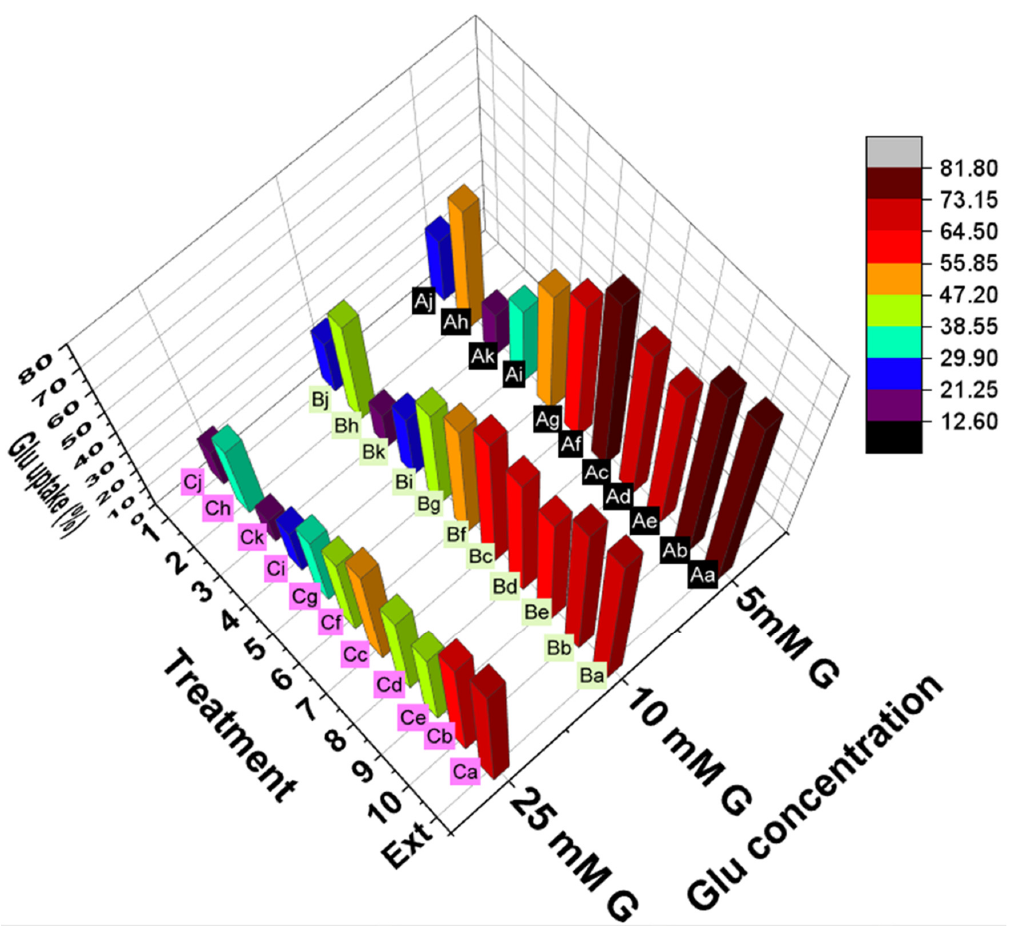
Figure 8. Glucose uptake by yeast cells exposed to different concentrations of glucose (5, 10, and 25 mM) in the presence of G. abyssinica extract or compounds 1 – 10. Lower-case letters indicate signifi- cant differences ( p < 0.05) between treatment conditions and upper-case letters indicate significant differences ( p < 0.05) between glucose concentrations .